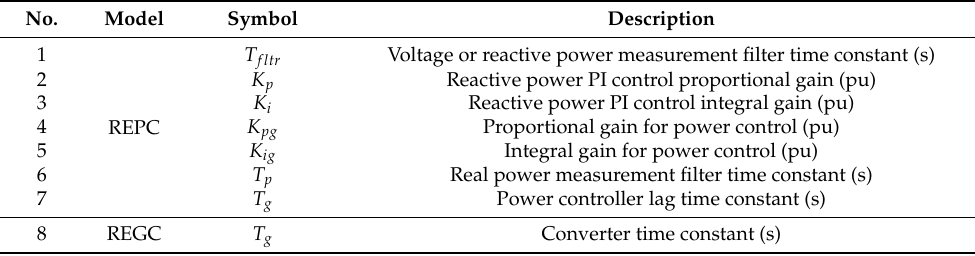
Table 6. The key parameter list.